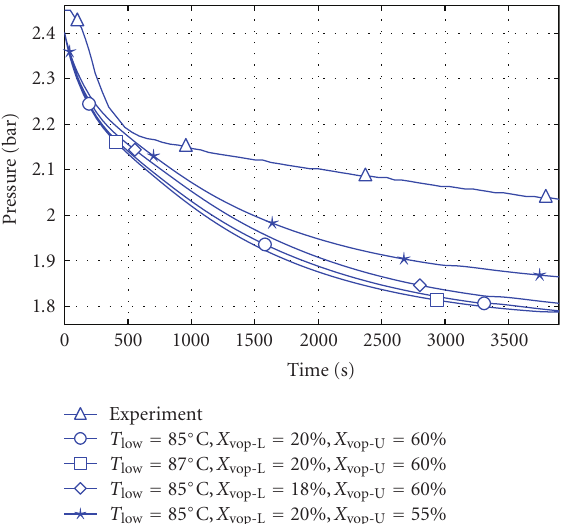
Figure 9: Pressure evolutions with di ff erent initial parameters.